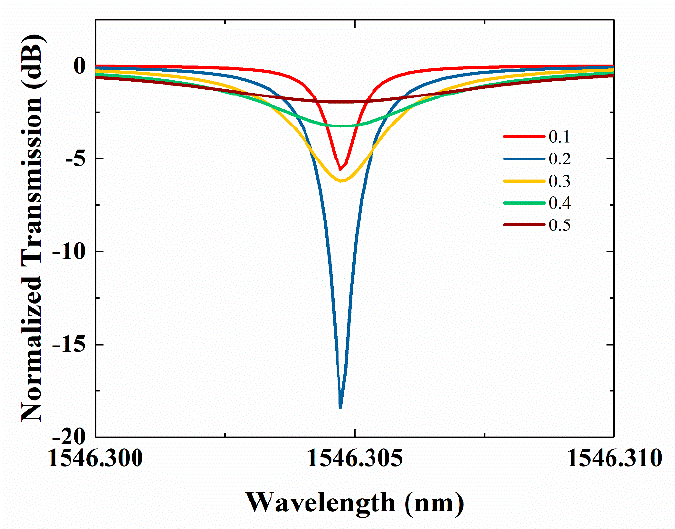
Figure 5. Relations between coupling efficiency and dip depth.